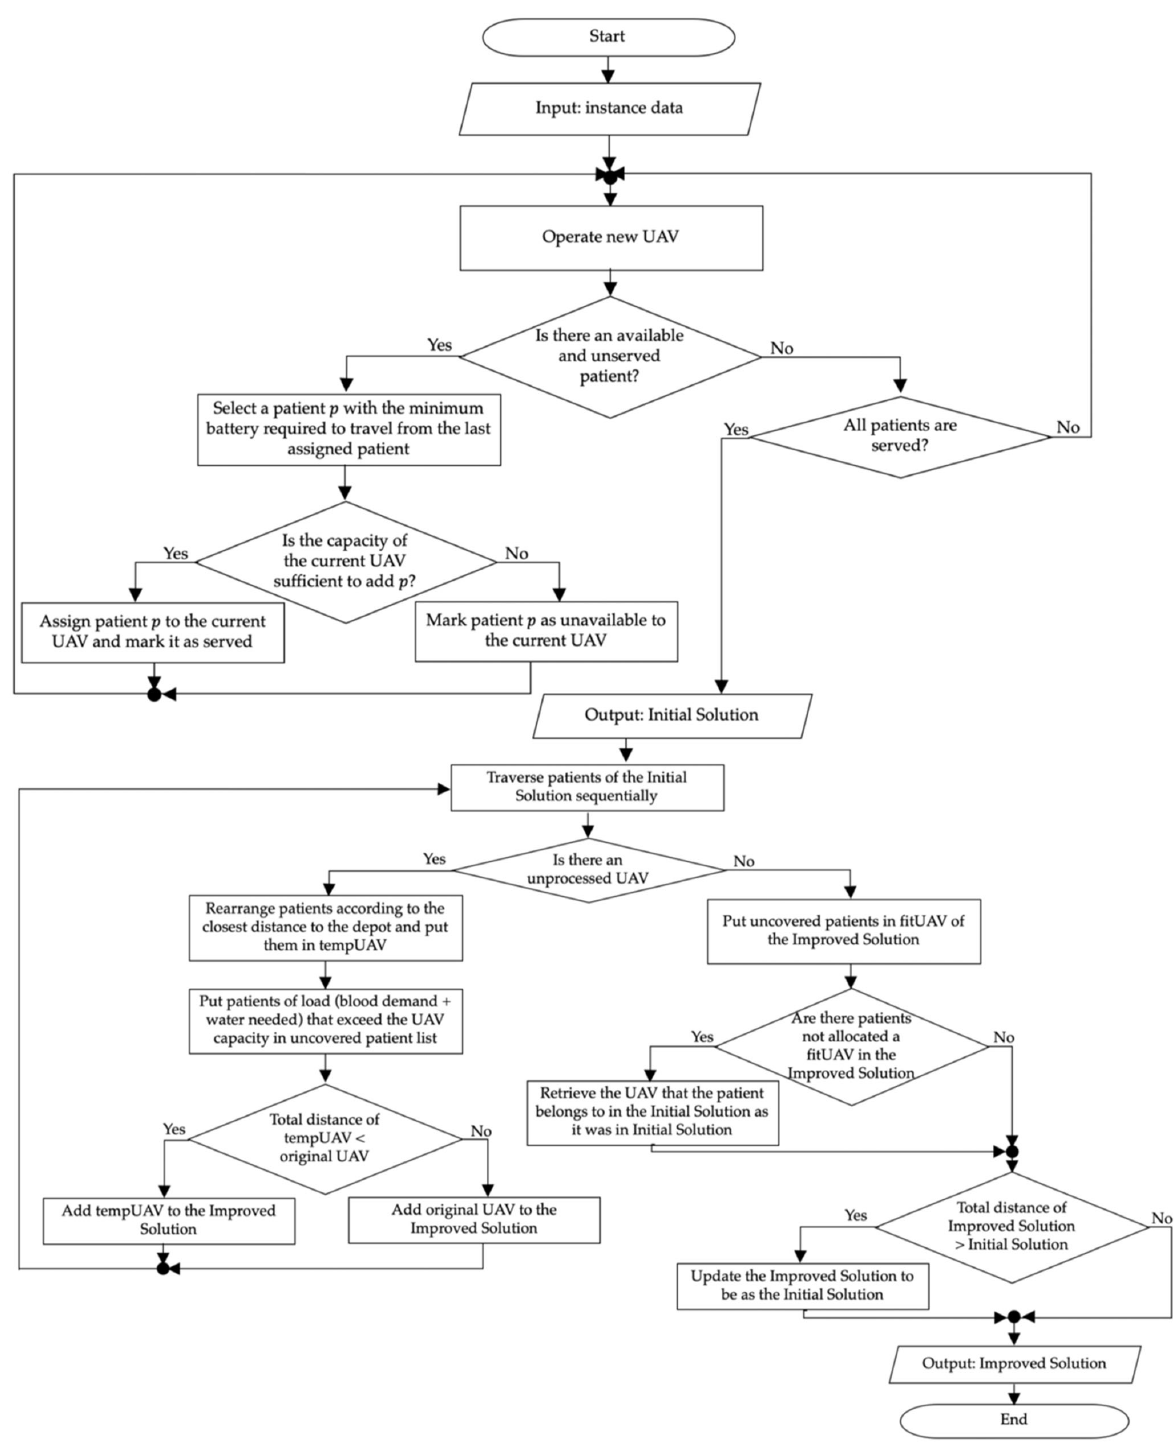
Figure 3. Flowchart of the GBDOH.